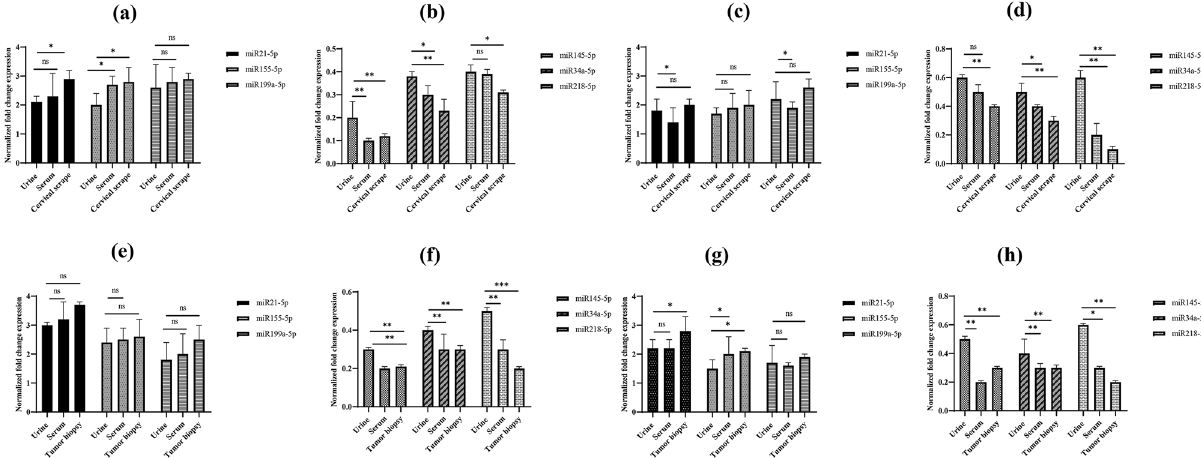
Figure 2. Expression levels of miR-21-5p, miR-155-5p, miR-199a-5p, miR-145-5p, miR-218-5p, and miR- 34a-5p in HPV16-positive ( a & c ) and HPV16-negative ( b & d ) urine, serum, and cervical scrape samples of cervical pre-cancer and in HPV16-positive ( e & g ) and HPV16-negative ( f & h ) urine, serum, and tissue biopsies of cervical cancer (Figure S3d and S3e) and the expression of miR-21-5p, miR-155-5p, and miR-199a-5p was significantly higher in HPV16 positive than HPV16 negative tissue biopsies of cervical cancer patients (Figure S3f.). Correlations of miRNA expression level with clinicopathological characteristics of cervical pre‑cancer and cancer.. The expression of all six miRNAs in urine, serum, cervical scrape, and tissue biopsies was correlated with various clinicopathological characteristics and known risk factors for cervical can- cer. Except miR-34a-5p in the urine and miR-34a-5p and miR-199a-5p in the serum, the expression of all other miRNAs was significantly correlated with the age of the cervical pre-cancer patients (Table S3). The expression